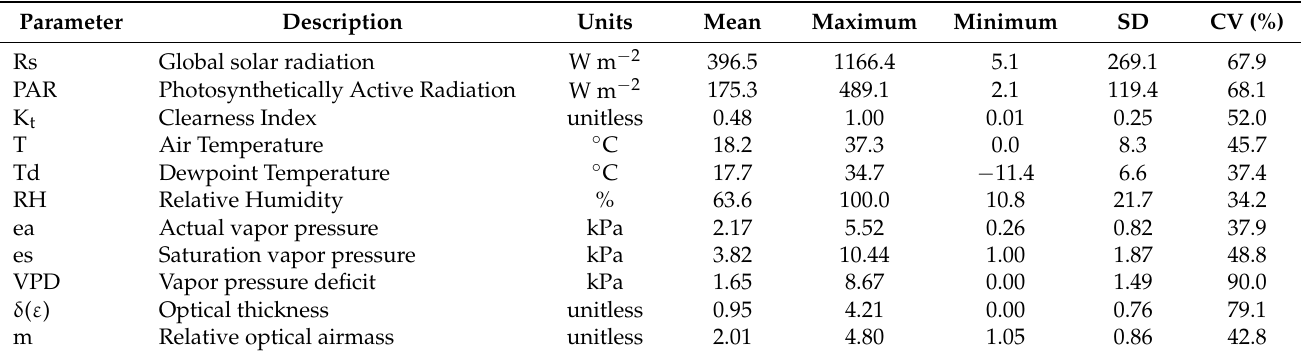
Table 1. Descriptive statistics of the measured and estimated meteorological factors for the filtered 10,522 hourly data of this study.